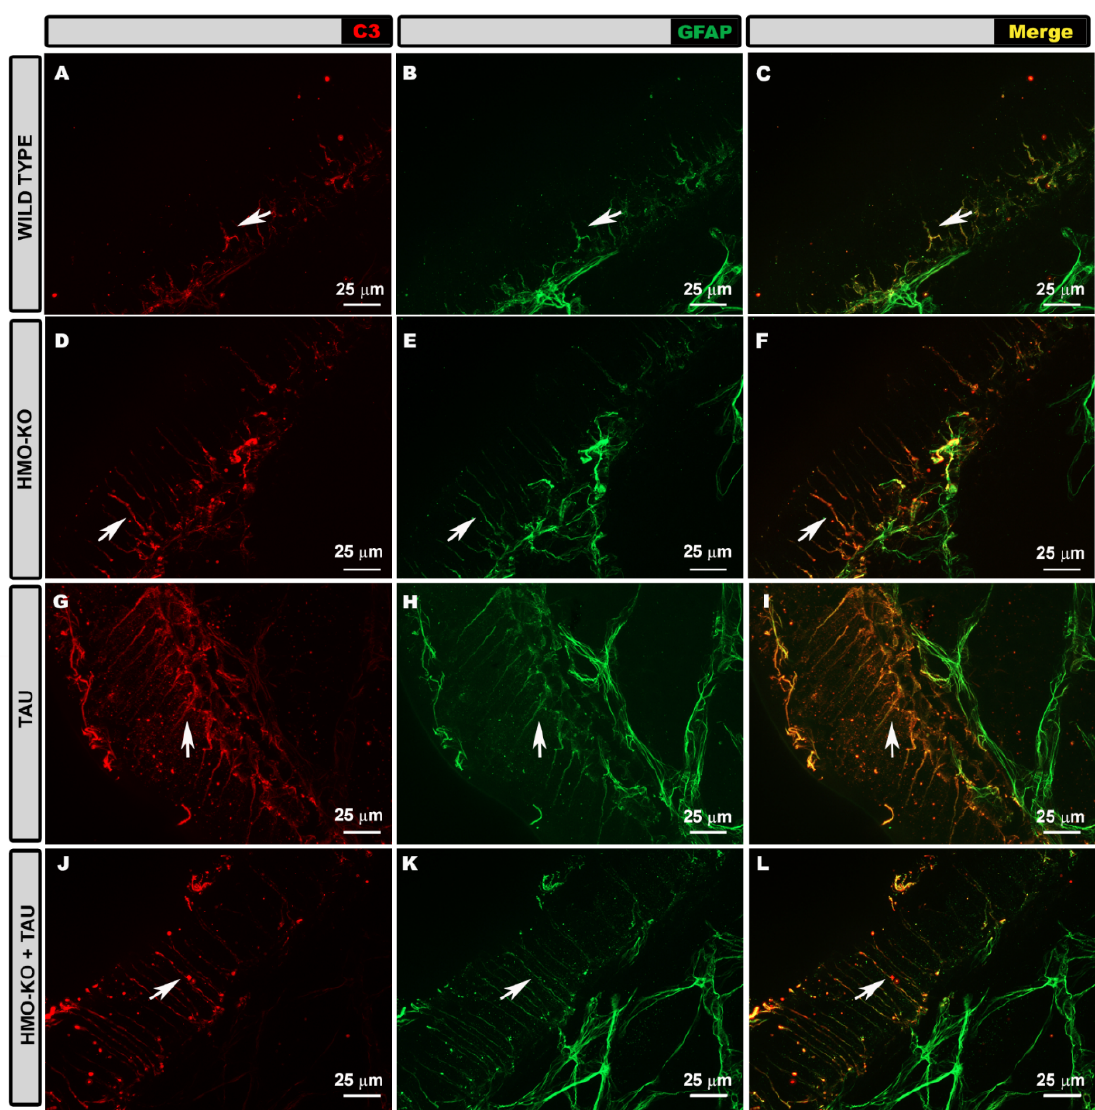
Figure 12. Retinal wholemount. Double immunohistochemical staining with anti-GFAP (green) and anti-C3 (red) in Müller cells in the different study groups: WT ( A – C ), HMO-KO ( D – F ), TAU ( G – I ), HMO-KO+TAU ( J – L ); 40× magnification. Arrows point to Müller cells. The image shows an edge of the retina, and therefore the entire thickness of the retina can be observed, allowing differentiation of the whole Müller cell as if it were a histological section. Number of retinas used in the experiment: WT n = 6, HMO-KO n = 6, TAU n = 6, and HMO-KO+TAU n = 6.